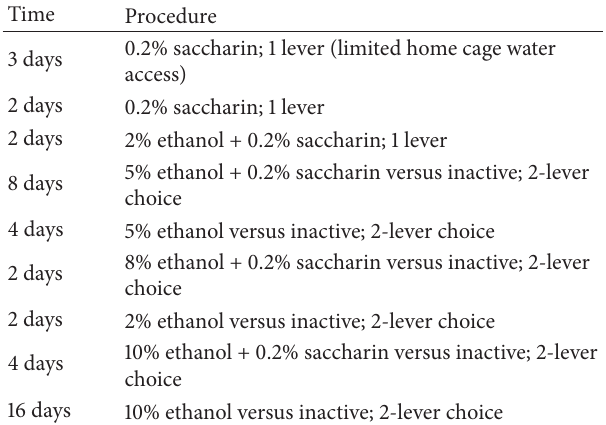
Table 1: Ethanol self-administration training